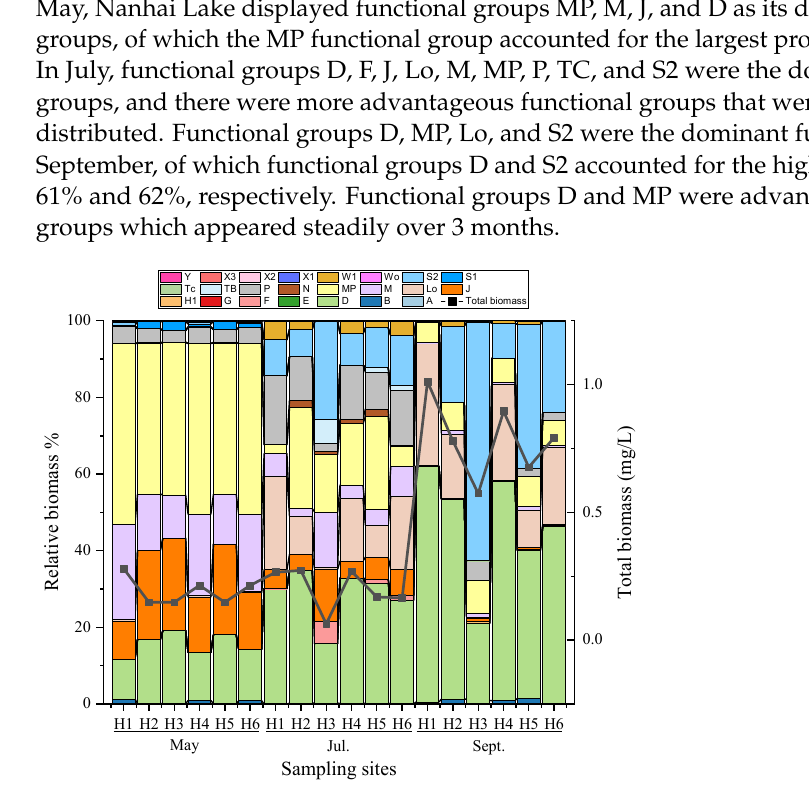
Figure 2. Frequency of phytoplankton functional groups in Nanhai Lake.